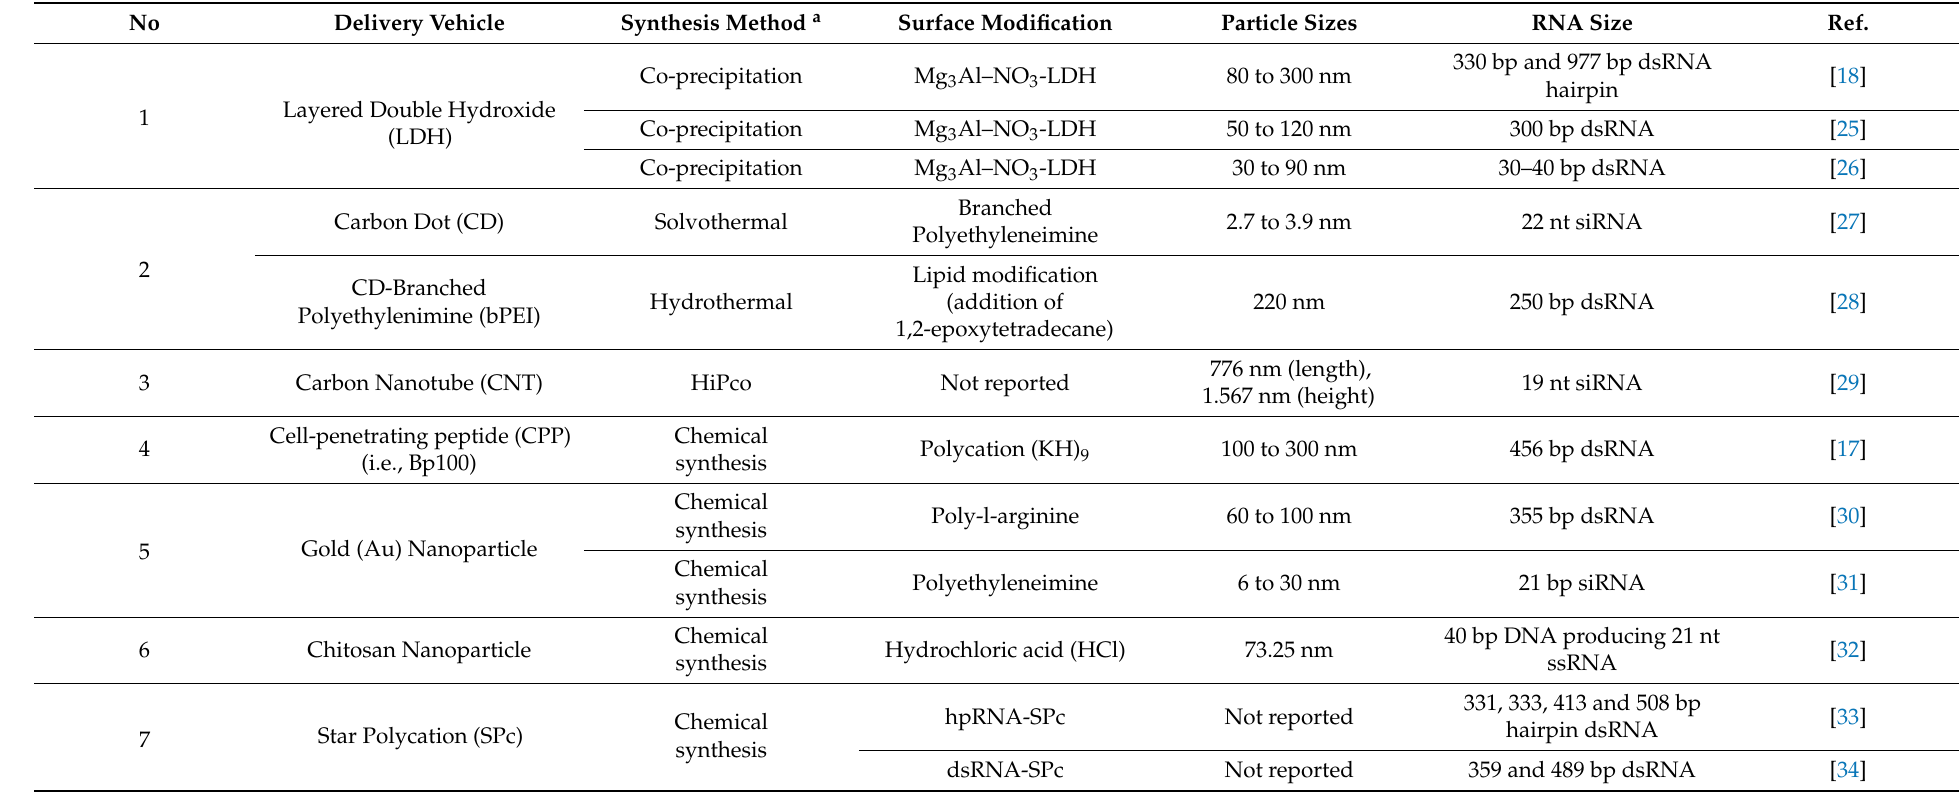
Table 1. Summary of various design strategies of delivery vehicles for RNAs. a Chemical synthesis method used for the preparation of the respective delivery